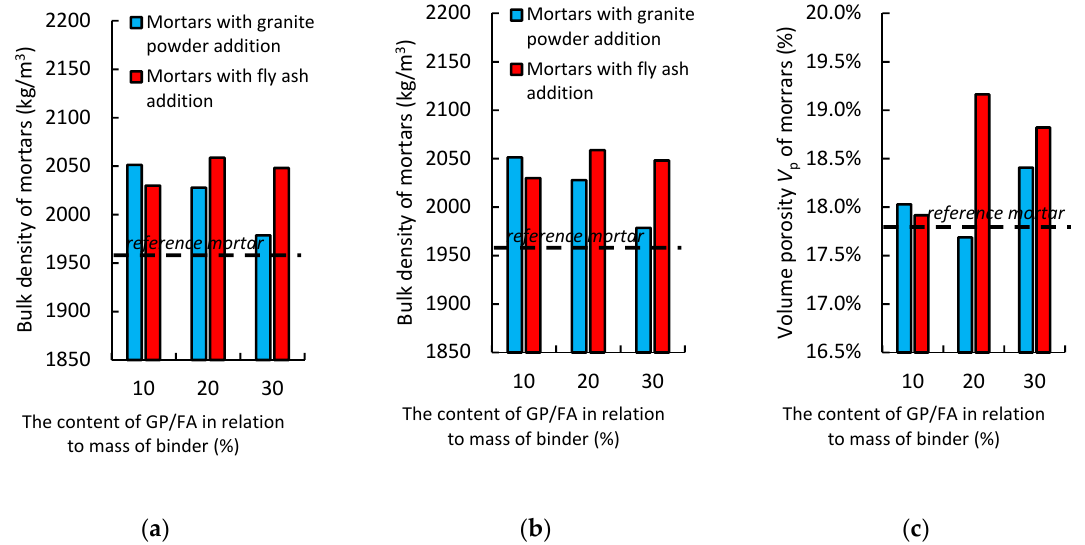
Figure 9. The effect of replacing the cement with the granite powder or fly ash on the following basic physical properties: ( a ) bulk density, ( b ) water absorption, and ( c ) volume porosity of the air-cured hardened cementitious mortars.